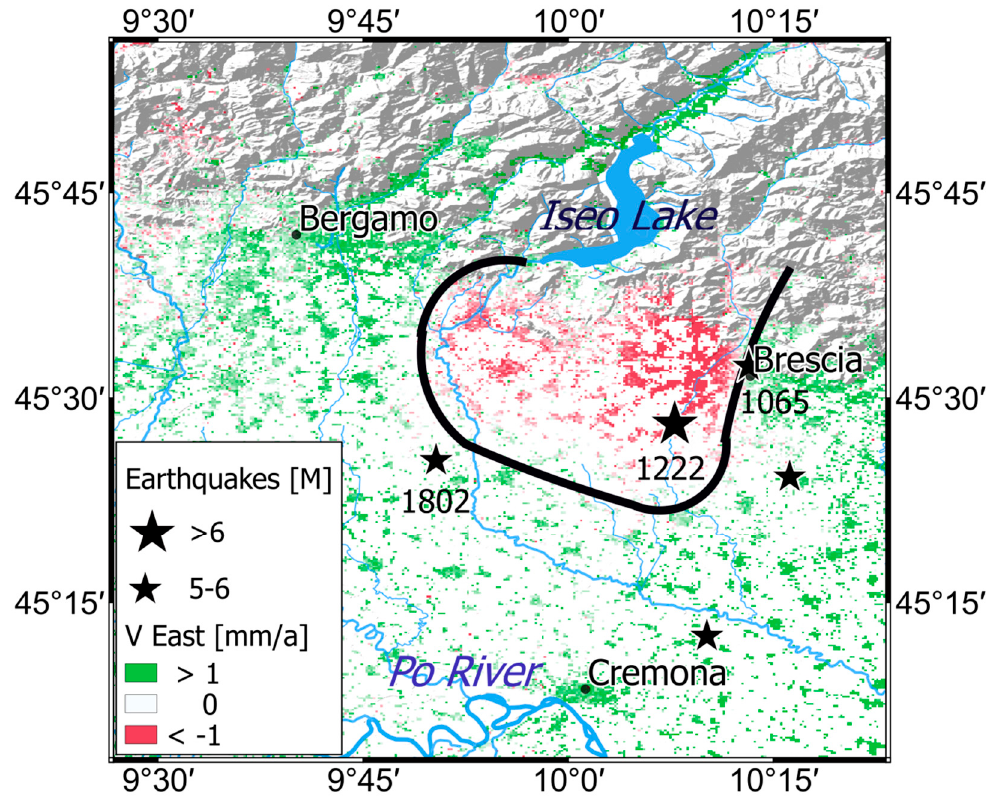
Figure 10. East component of the velocity field in Brescia and the main historical earthquakes (years 1065, 1222, and 1802). The black line marks the boundary of the two kinematic zones that run in opposite directions.